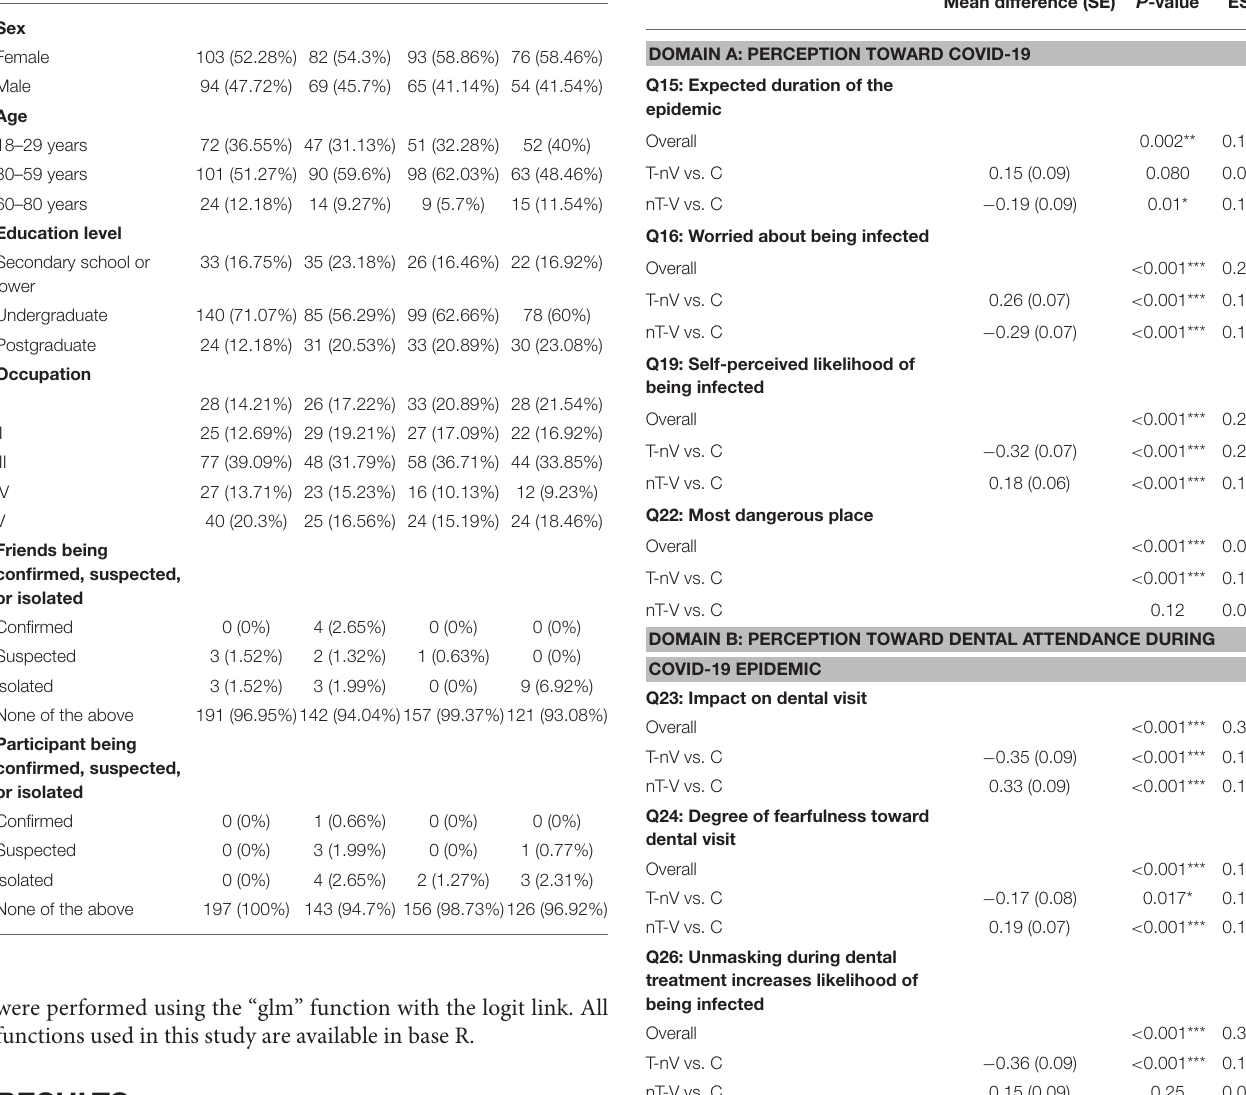
epidemic. Mean difference (SE) P